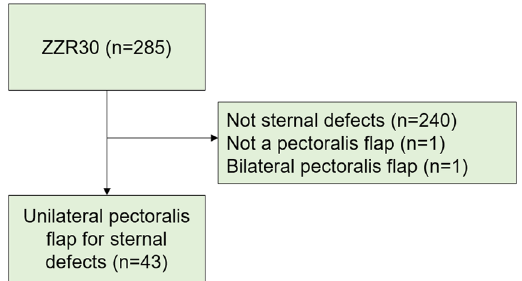
Figure 1. Flowchart showing the selection of patients. ZZR30 is the ICD-10-SE procedure code for “reconstruction with a muscle flap”. A total of 45 reconstructions of sternal defects were done with muscle flap, 43 with a unilateral pectoralis muscle flap, one with bilateral pectoralis muscle flaps and one with another muscle flap.